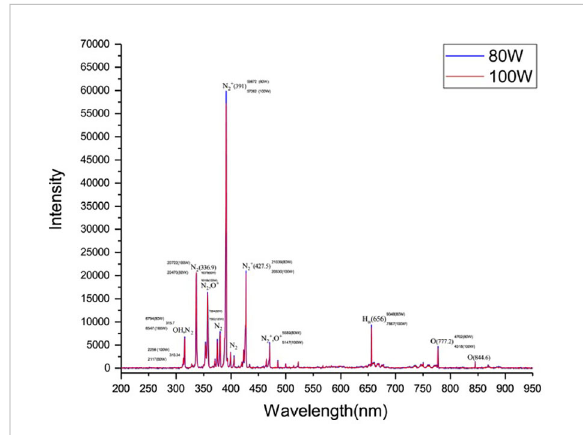
FIGURE 1 The optical emission spectrum of low-pressure glow discharge in the air at the power of 80 (left) and 100 (Right)